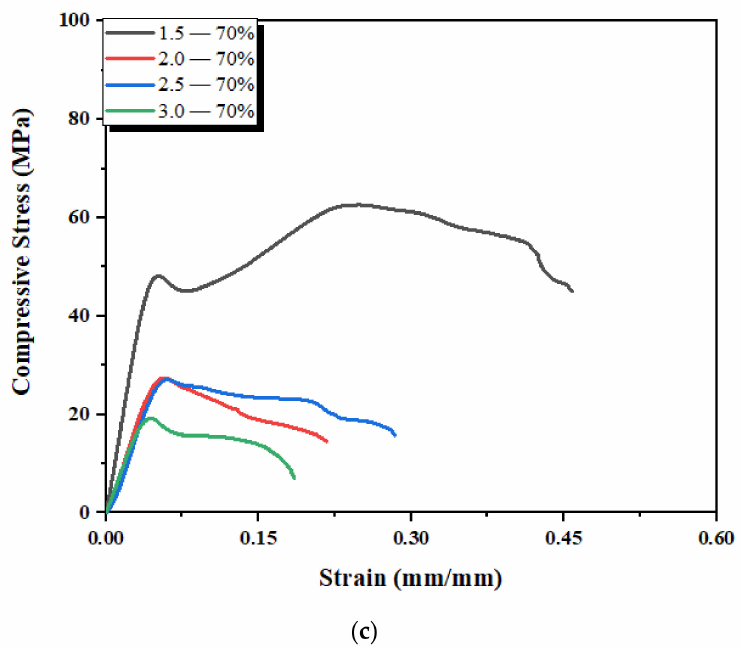
Figure 10. Stress–strain curves of PolyJet 3D-printed scaffold structures with a cubic pore shape at